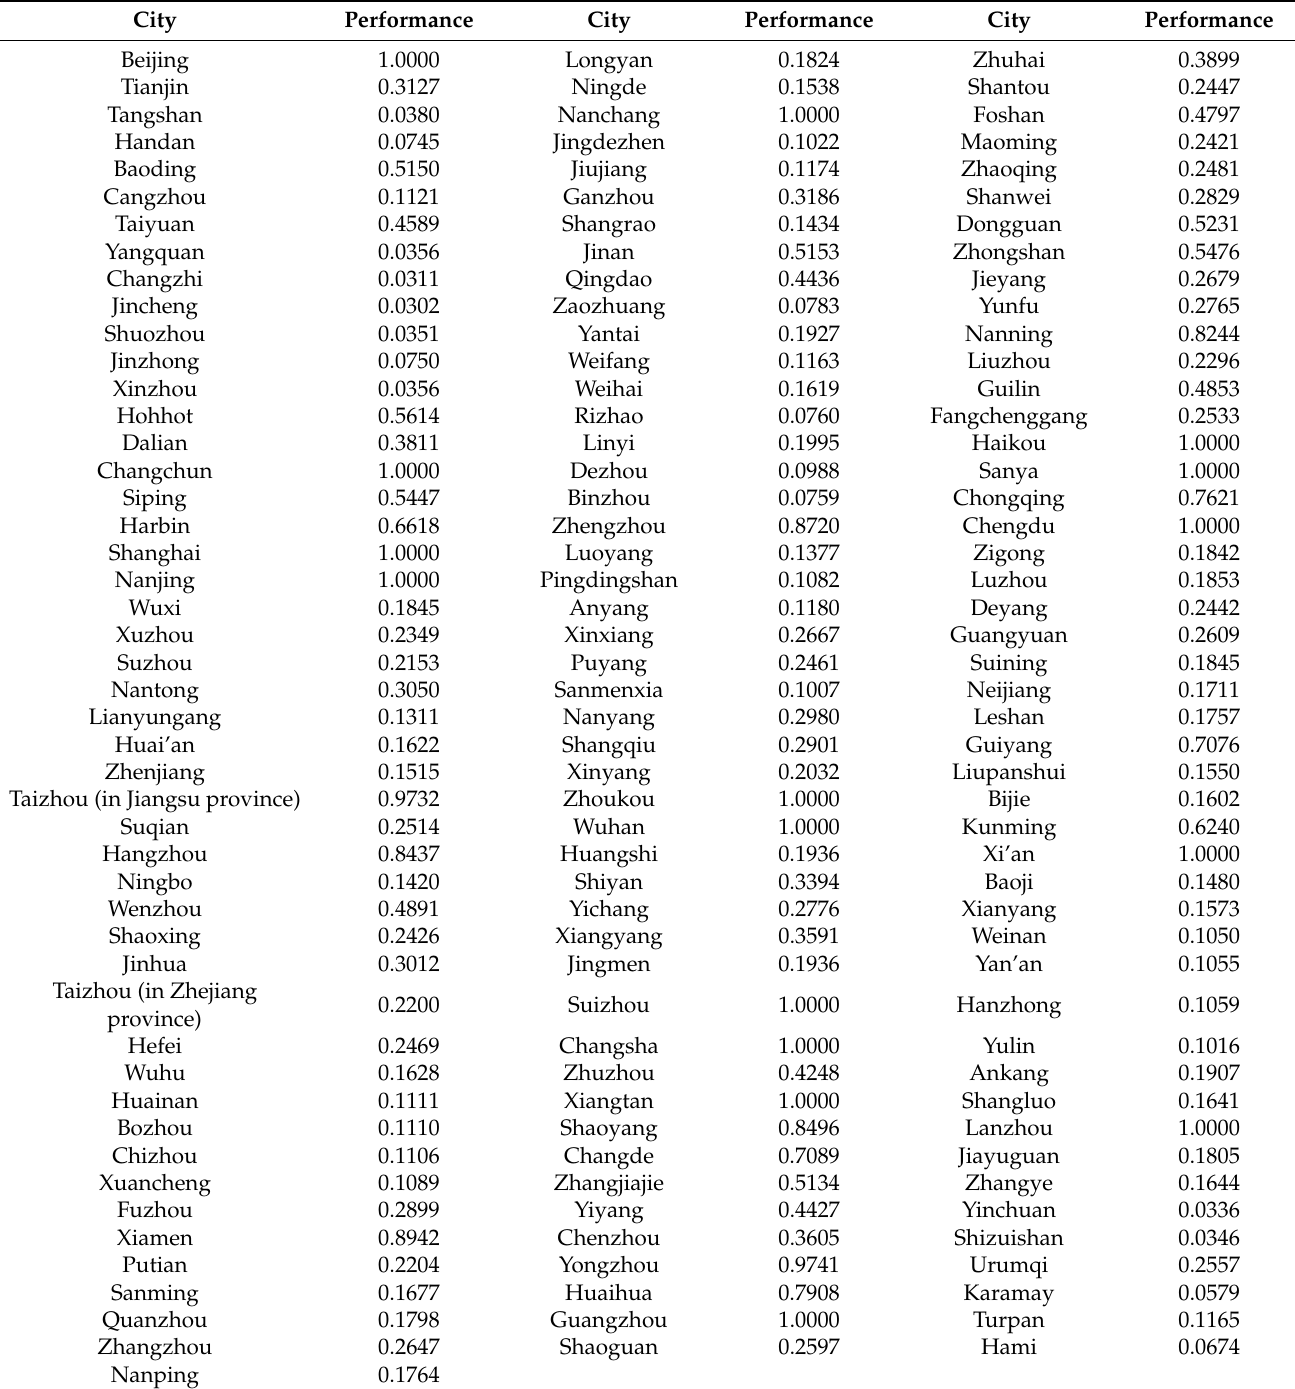
Table 4. The measurement results of energy performance of prefecture level cities in China in the well-being dimension. City Performance City Performance City